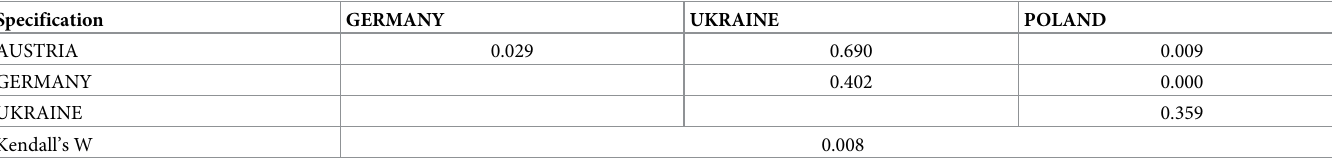
Table 2. Results of Spearman’s rho correlation coefficient and Kendall’s W concordance coefficient significance tests (p-value) for the ranking lists of actions con- tributing to innovation-friendly organisational culture. Specification